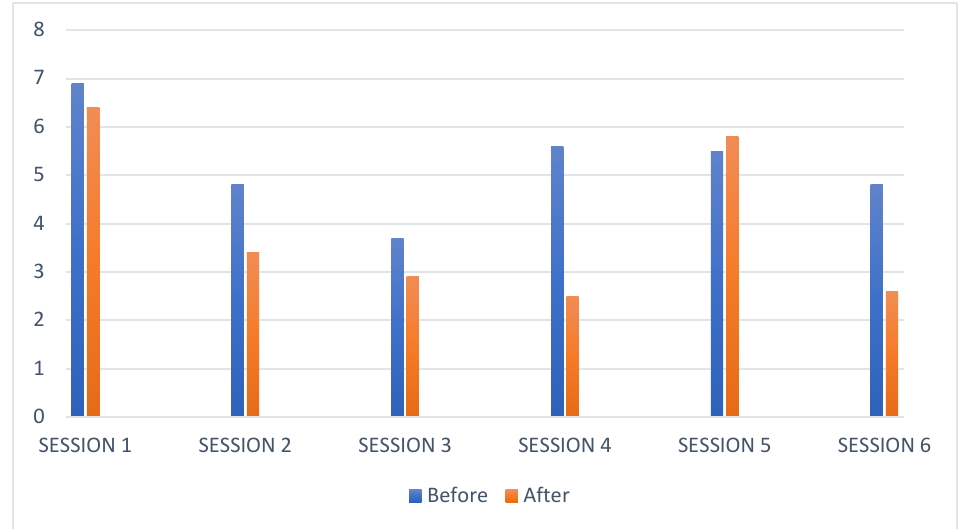
Figure 1. Participant 1 stress level bar chart.